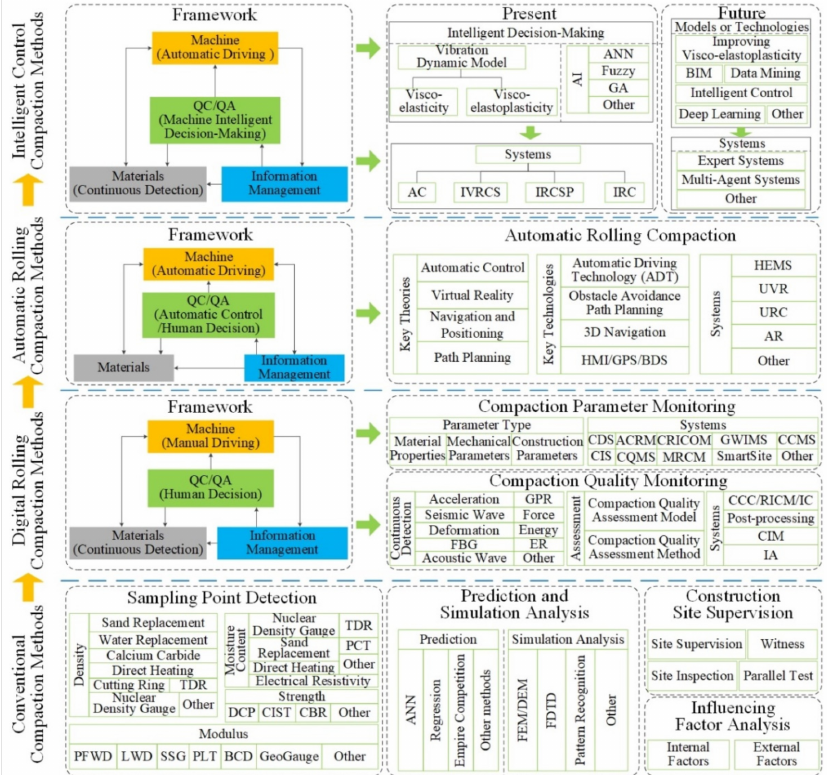
Figure 6. Classification of compaction quality control and assurance methods for